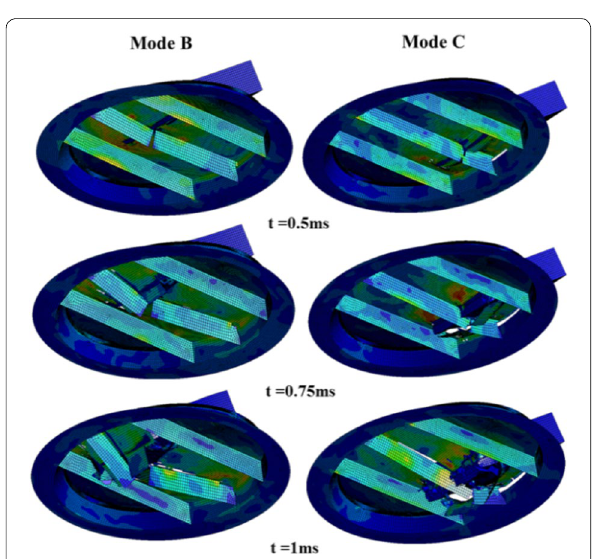
Figure 12 Failure patterns with mode B and mode C (aluminium alloy by precision